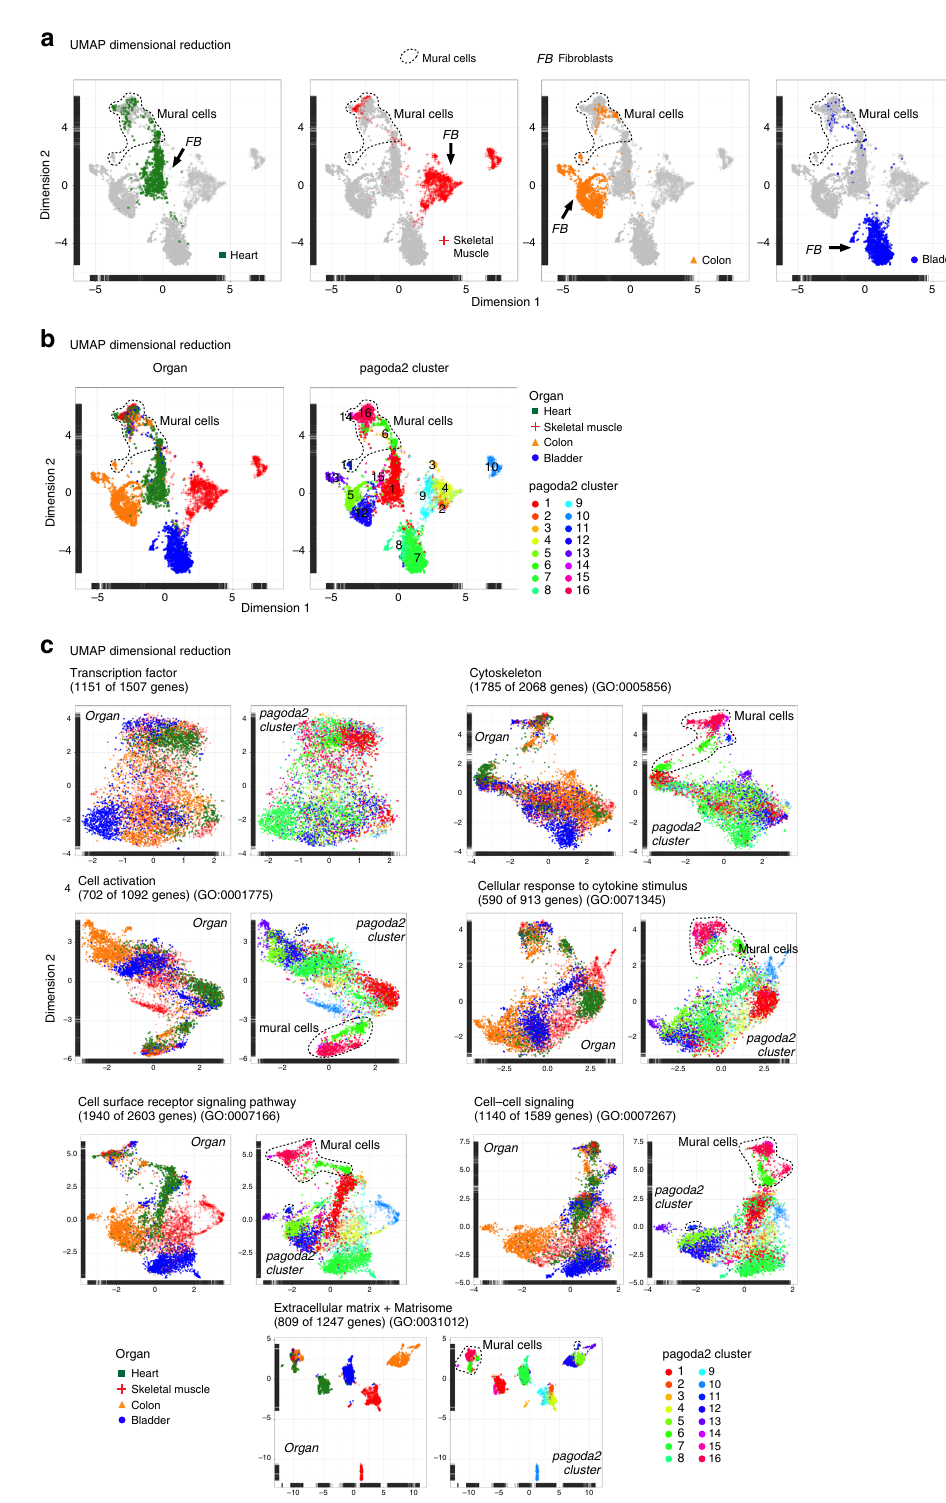
Fig. 2 Cell dispersion criteria. a UMAP visualization of the complete dataset, color coded for th respective organ of origin, separately. Cell clouds containing mural cells or fi broblasts are indicated. b UMAP visualization color coded for the organ of origin or pagoda2 clustering result. c UMAP visualization using restricted gene-sets color coded for the organ of origin combined, or pagoda2 clustering result. Cell clouds containing mural cells are indicated (see also Supplementary Data